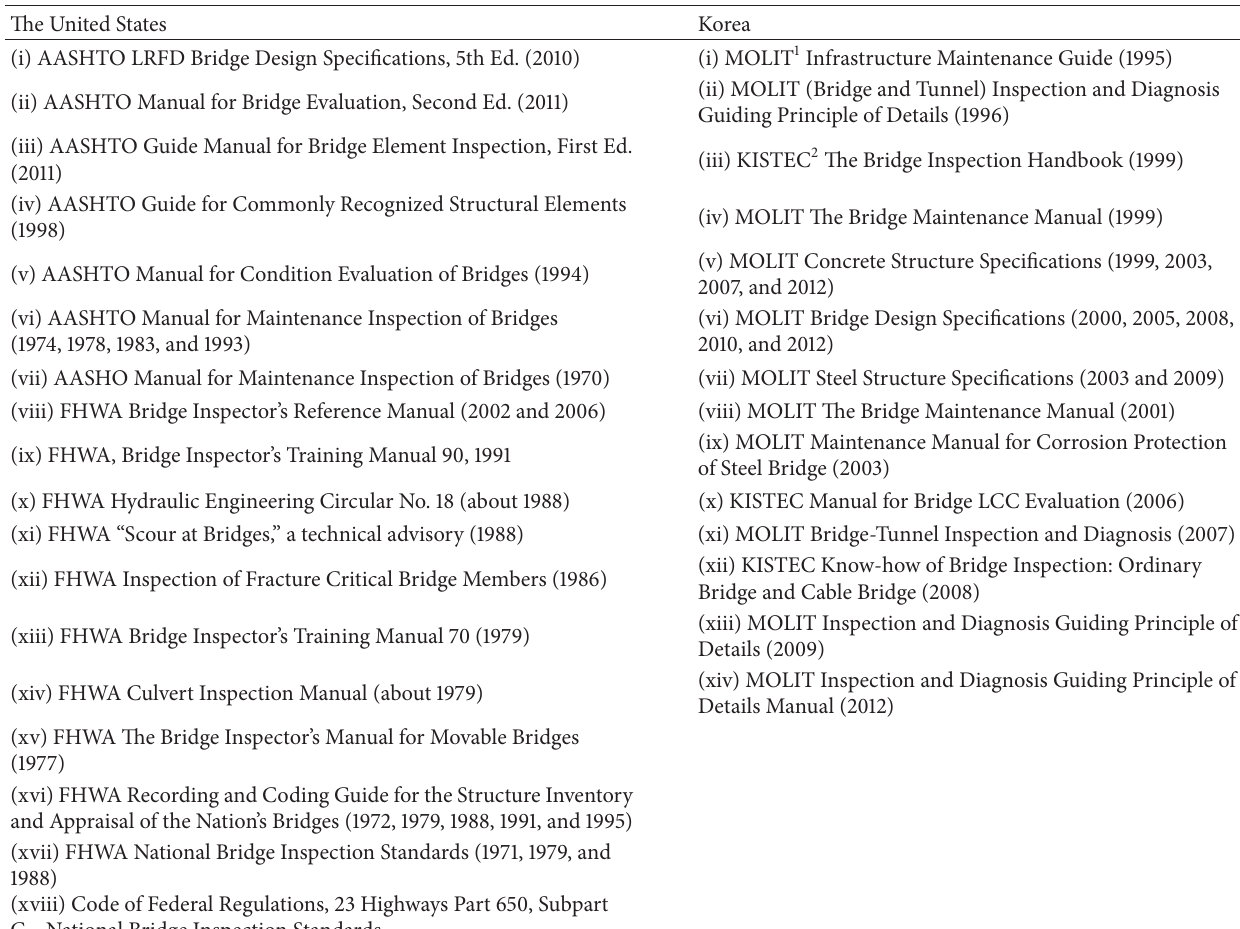
Table 1: Bridge inspection standards in the United States and Korea. The table is modified from [6]. The United